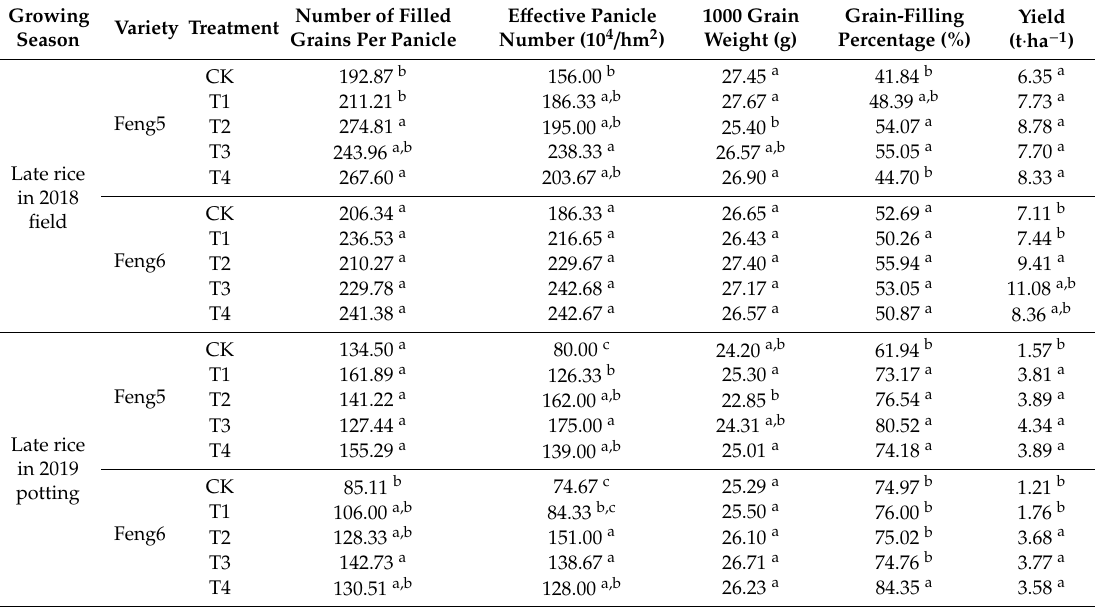
Table 2. Changes of yield and components of giant rice under di ff erent nitrogen treatments.